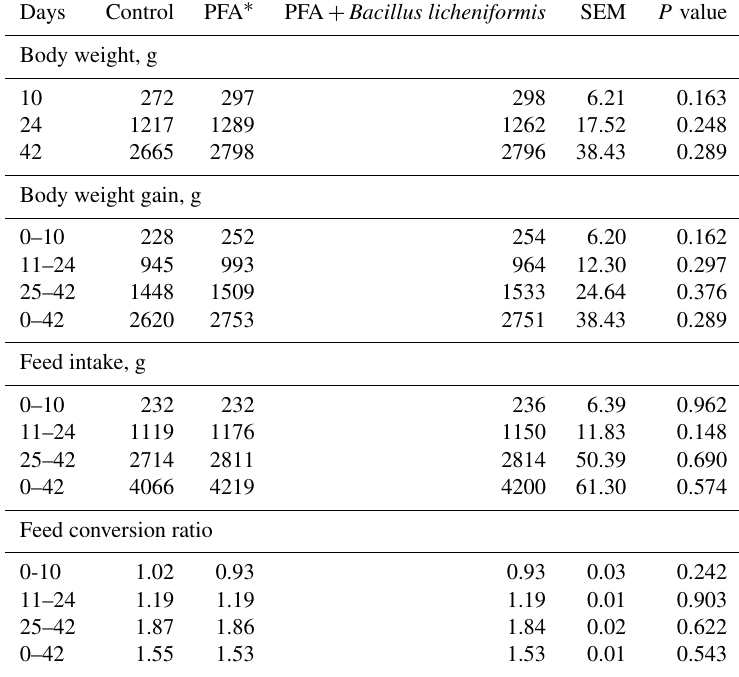
Table 2. Growth performance of broiler chickens fed supplemental phytogenic feed additive alone or in combination with Bacillus licheni- formis .